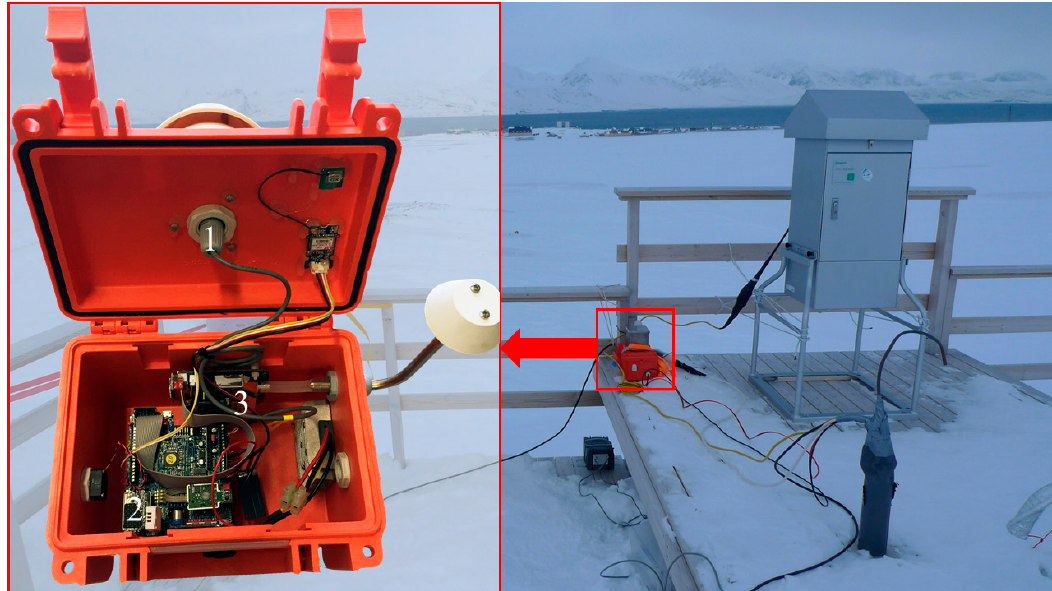
Figure 2. Positioning of the low-cost sensor array (AIRQino) on the roof of the Gruvebadet Atmospheric Laboratory (GAL) and interiors of the rugged enclosure highlighting the temperature (T) and relative humidity (RH) sensor ( 1 ), the CO 2 sensor ( 2 ), and the particulate matter (PM) sensor ( 3 ). The snow protection cage is visible in the small red box on the right on top of the AIRQino.